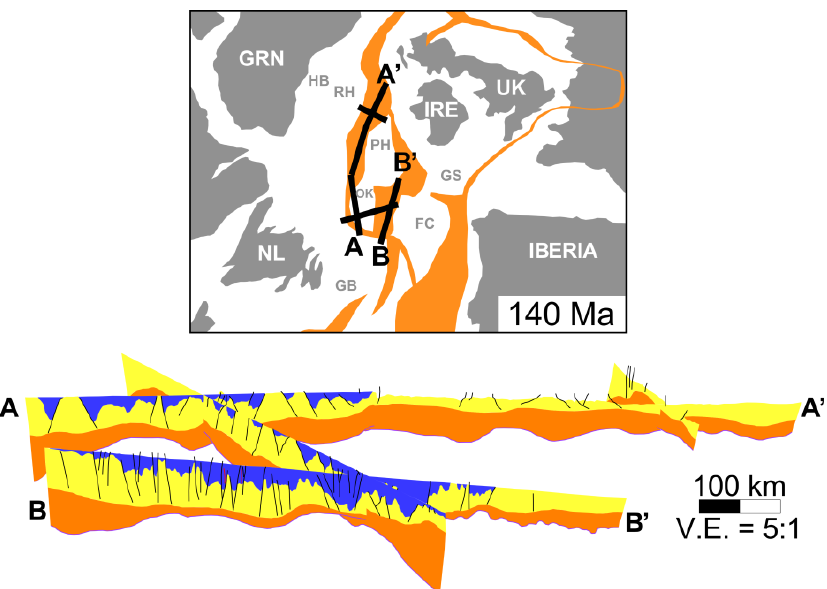
Figure 11. Simplified map of reconstruction from [24] at 140 Ma showing modern landmasses (gray), rifts (orange), and locations of the investigated seismic lines (thick black lines) above a 3D reconstruction with profile A to A’ connecting seismic lines NL1 and IR1 and profile B to B’ representing seismic line NL3. Black lines represent primary faults and red lines represent secondary faults. For meaning of layer colours, see legend in Figure 6.